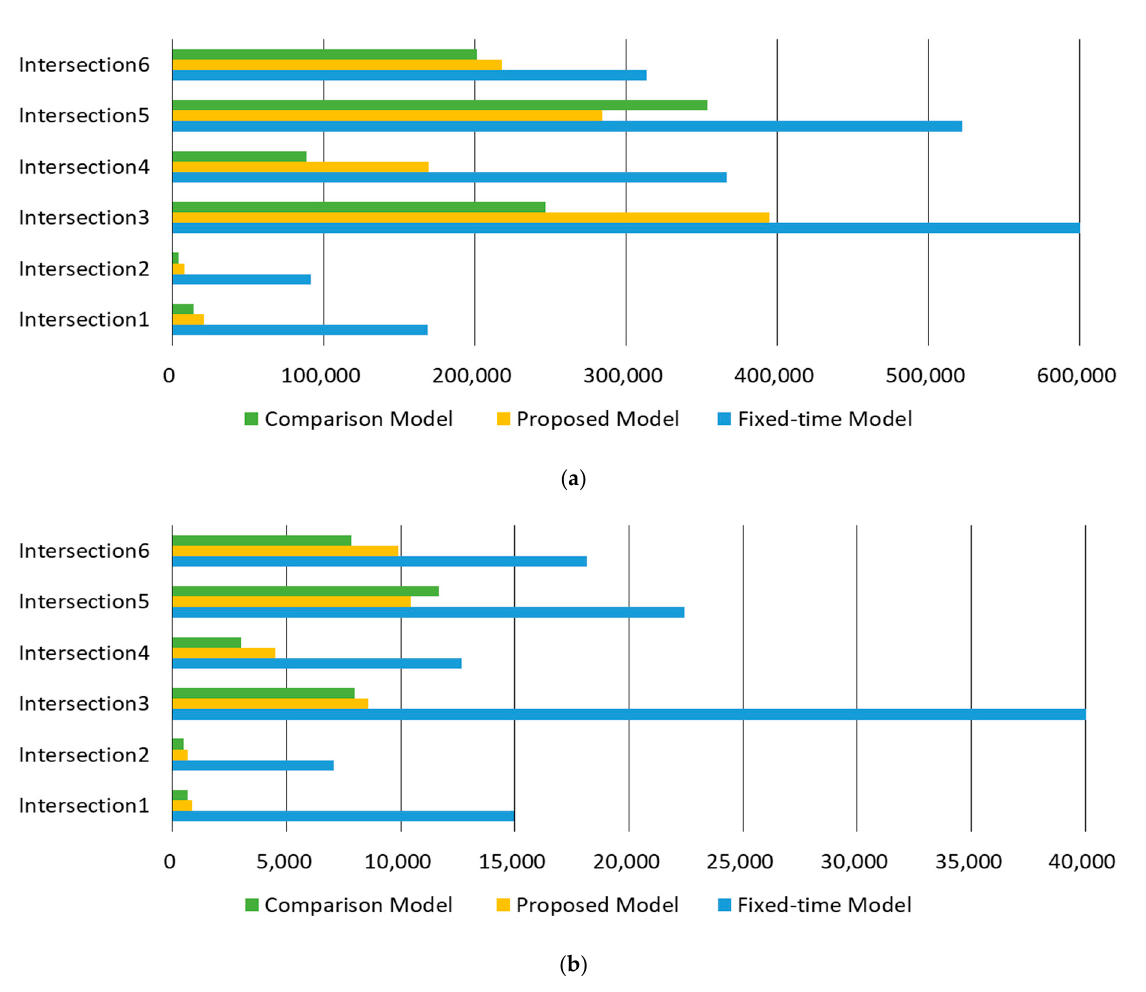
Figure 7. Measure of effectiveness by intersections: ( a ) Cumulative delay; ( b ) Cumulative number of stops.